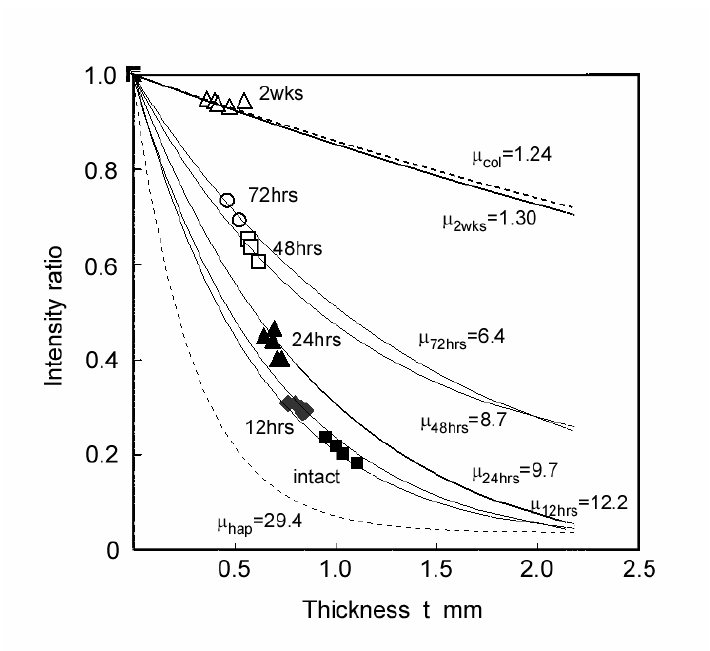
Fig. 2 Transmitted X-ray fraction I / I 0 at different demineralized duration. The linear absorption coefficients were calculated by approximating the relationships between the transmitted X-ray fraction and thickness of cortical bone